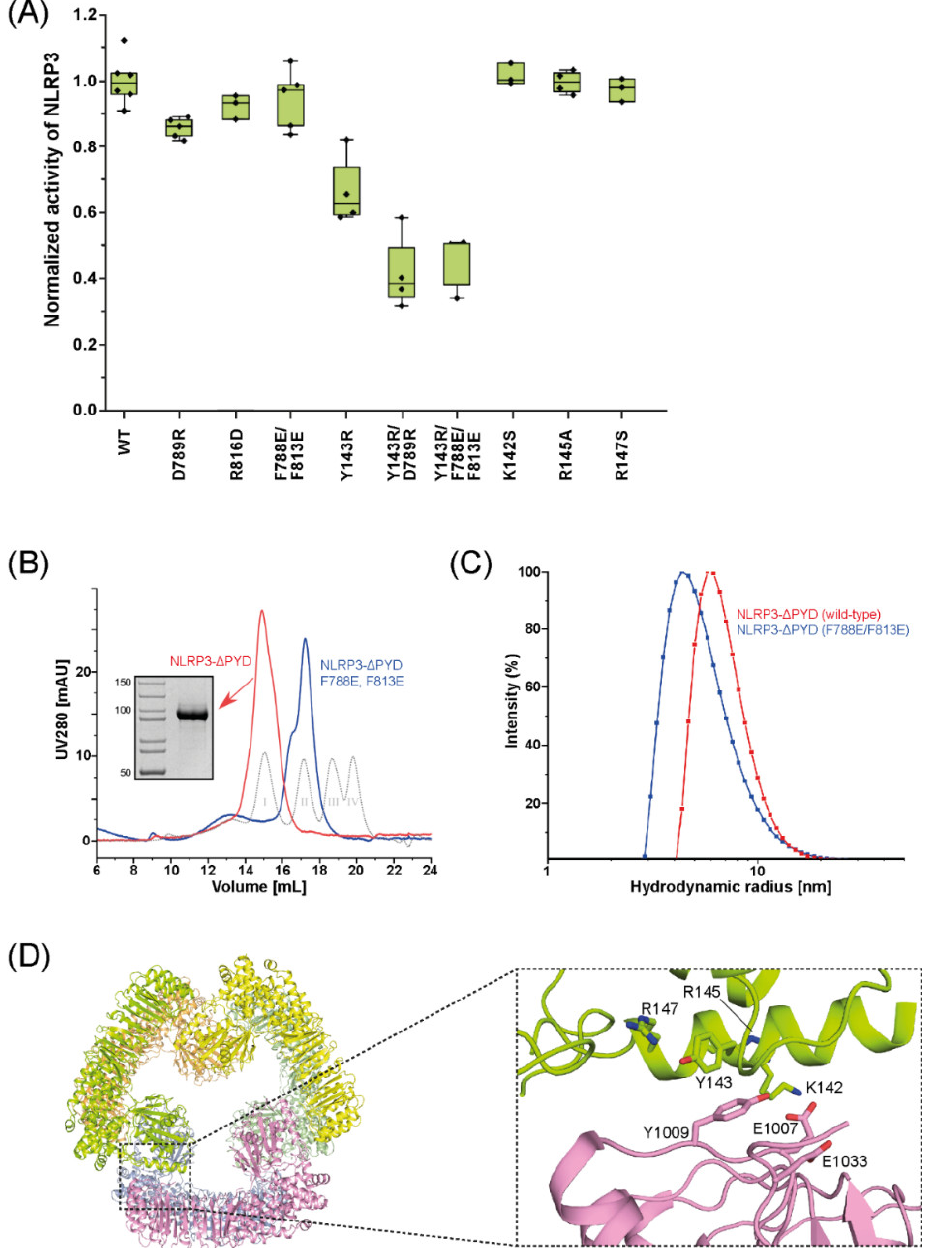
Figure 3. Characterization of NLRP3 mutants. ( A ) Quantification of HEK293-ASC cells containing ASC specks after transfection of wild-type or mutant NLRP3. Box plots represent the ratio of speck- positive cells to the total of transfected cells. They show the interquartile range (IQR) and the median. Each dot represents one experiment. Whiskers include experiments within 1.5 × IQR. For each experiment, six images were counted with at least one hundred cells each; ( B ) Size exclusion chromatography of wild-type NLRP3 ∆ PYD (red) and NLRP3 ∆ PYD-F788E/F813E (blue). Peaks corresponding to marker proteins (I: Thyroglobulin, 669 kDa; II: Ferritin, 440 kDa; III: Aldolase, 158 kDa; IV: Ovalbumin, 44 kDa) are shown as gray dotted lines; ( C ) Dynamic light scattering of wild-type NLRP3 ∆ PYD (red) and NLRP3 ∆ PYD-F788E/F813E (blue). The peak representing the mutant is shifted to a smaller hydrodynamic radius; ( D ) ( Left ): Cartoon representation of the top view of the NLRP ∆ PYD hexamer. ( Right ): Close-up view of the NOD–LRR interface. Amino acids involved in the interface are shown in stick representation and are labelled according to the sequence numbering of human NLRP3.